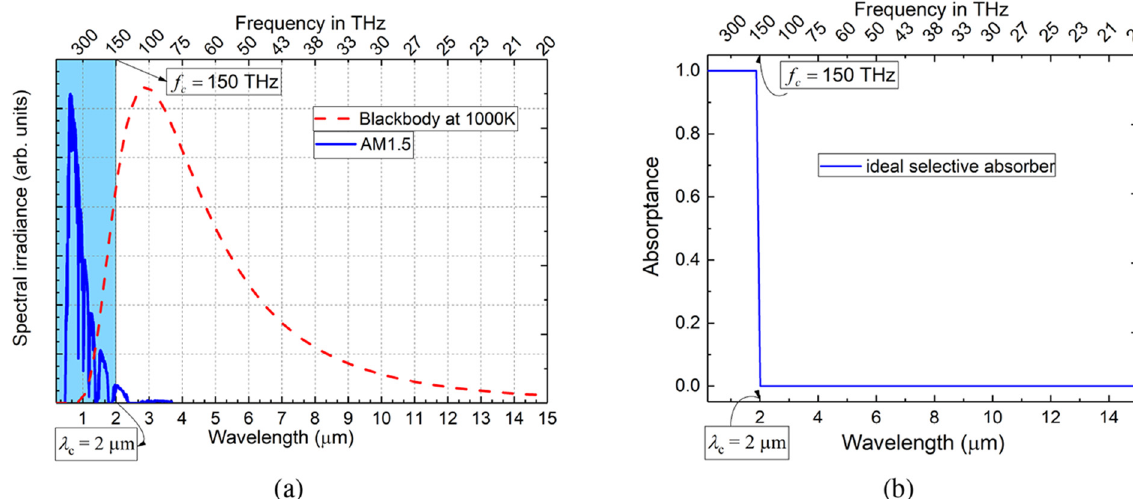
Fig. 1. (a) AM1.5 spectrum (solar spectrum at sea level for a solar zenith angle of 48.2 ° ) [10], and blackbody spectrum (in dashed red) corresponding to 1000 K. (b) Desired absorptance spectrum in an ideal absorber